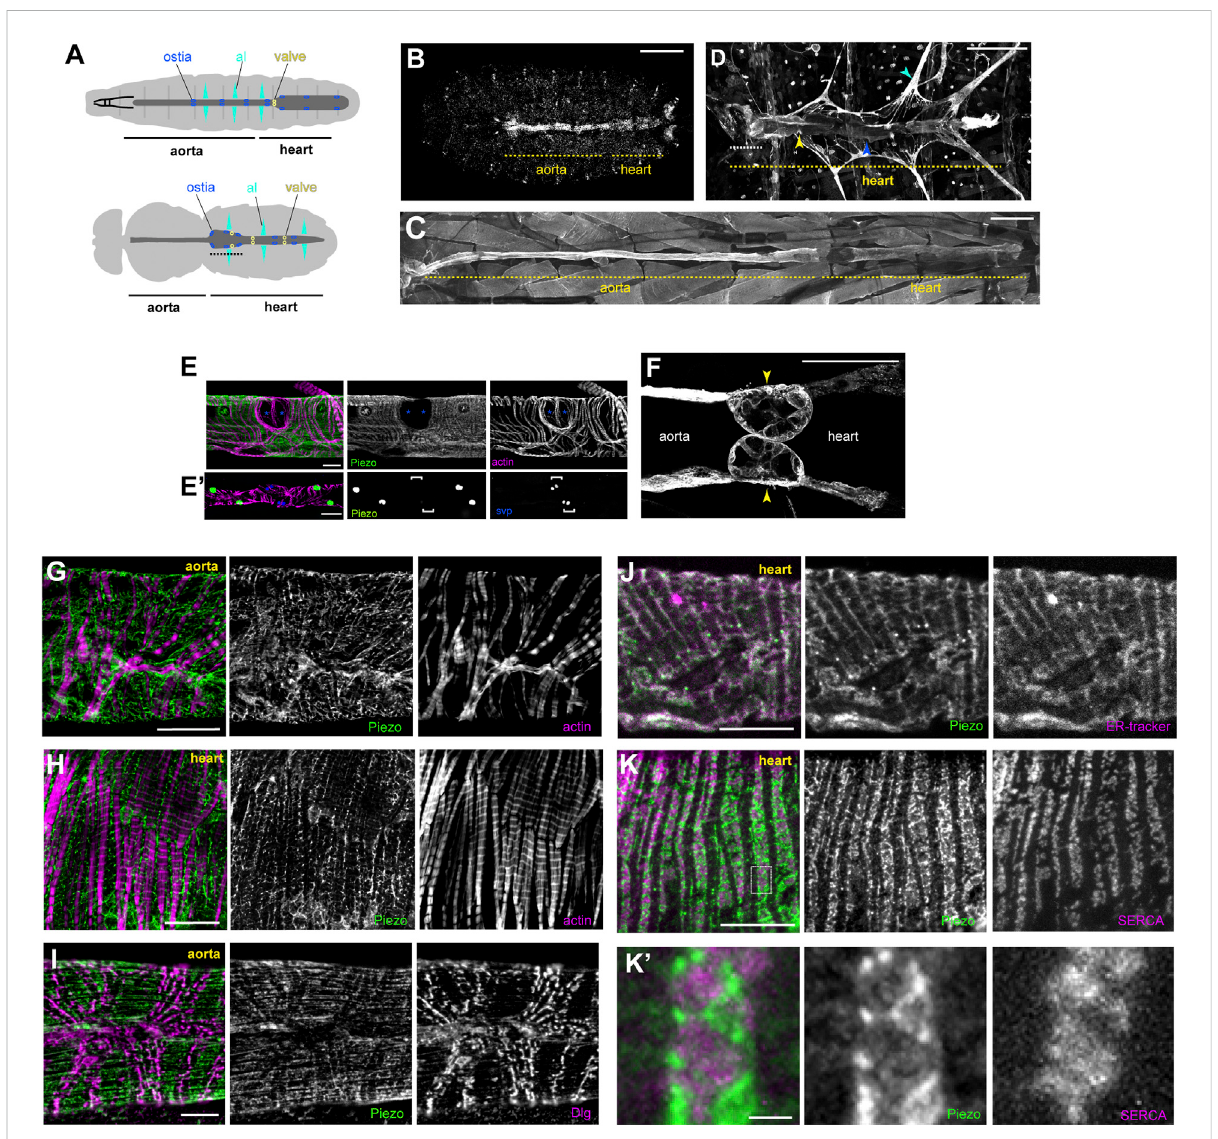
FIGURE 1 Piezo expression in the Drosophila heart. (A) Schematic fi gure of a Drosophila larva (upper) and adult (lower) depicting the heart, aorta and associatedcelltypes.Cardiomyocytes(darkgrey),ostia(blue),intracardiacvalves(yellow),andalarymuscles(al,cyan)areshown.Conicalchamberis indicated with dashed line. (B) Piezo expression in a late stage Drosophila embryo revealed by in situ hybridization chain reaction. (C) Piezo expression in a larva revealed by Piezo-Gal4 > UAS-Piezo::GFP . (D) Piezo expression in an adult revealed by Piezo-Gal4 > UAS-Piezo::GFP . Conical chamber is indicated with dashed line. (E) Piezo-Gal4 > UAS-nRFP (green), seven up-LacZ (blue, bracket in E 9 ) and actin (magenta) reveal Piezo expressionincardiomyocytesbutnotostia. (F) Piezo expressioninlarvalintracardiacvalves(yellowarrowheads)revealedby Piezo-Gal4 > UAS- Piezo::GFP . (G,H) Piezo subcellular localisation revealed by Piezo-Gal4 > UAS-Piezo::GFP (green) in the aorta (G) and heart (H) in relation to actin fi laments (magenta). (I) Piezo subcellular localisation revealed by Piezo-Gal4 > UAS-Piezo::GFP (green) in the aorta relative to T-tubule marker anti- Discs large (Dlg, magenta). (J) Piezo subcellular localisation revealed by Piezo-Gal4 > UAS-Piezo::GFP (green) in the heart relative to the SR marker (ER-tracker, magenta). (K) Piezo subcellular localisation revealed by Piezo-Gal4 > UAS-Piezo::GFP (green) in the heart relative to the SR marker anti- Serca (magenta). (K 9 ) shows a higher magni fi cation view of the box marked in (K) . Scale bars = 100 µm (B, E ′ ), 200 µm (C,D) , 50 µm (E,F) , 20 μ m, (G,H) , 10 µm (I – K) , 2 µm (K ′ ). For all images anterior is to the